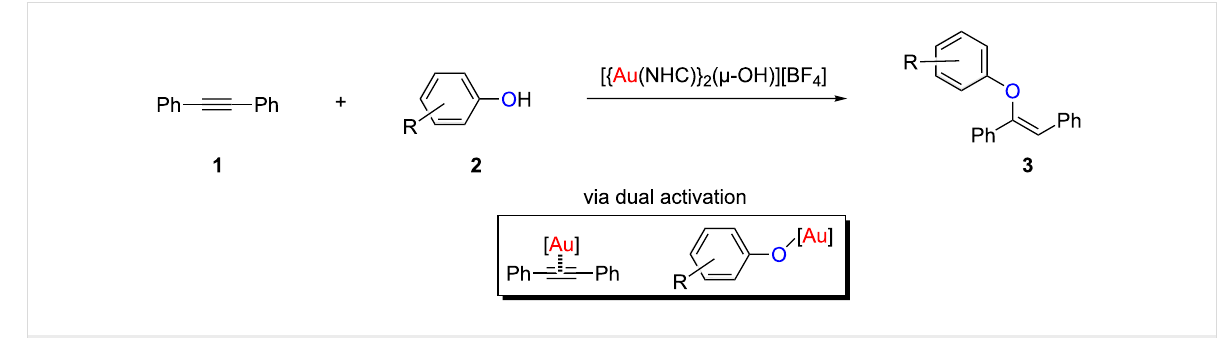
Scheme 1: Dual-gold-catalysed hydrophenoxylation of